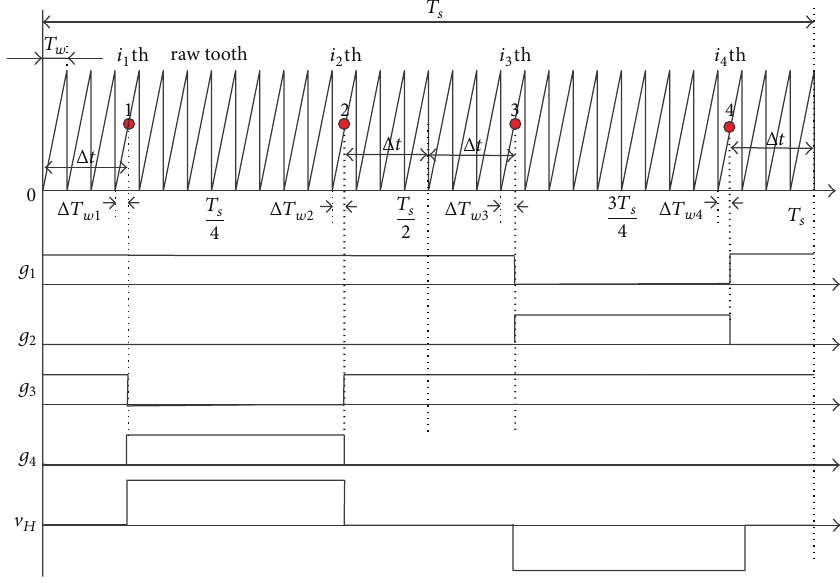
Figure 19: Proposed pulse generation scheme according to the switching angles.